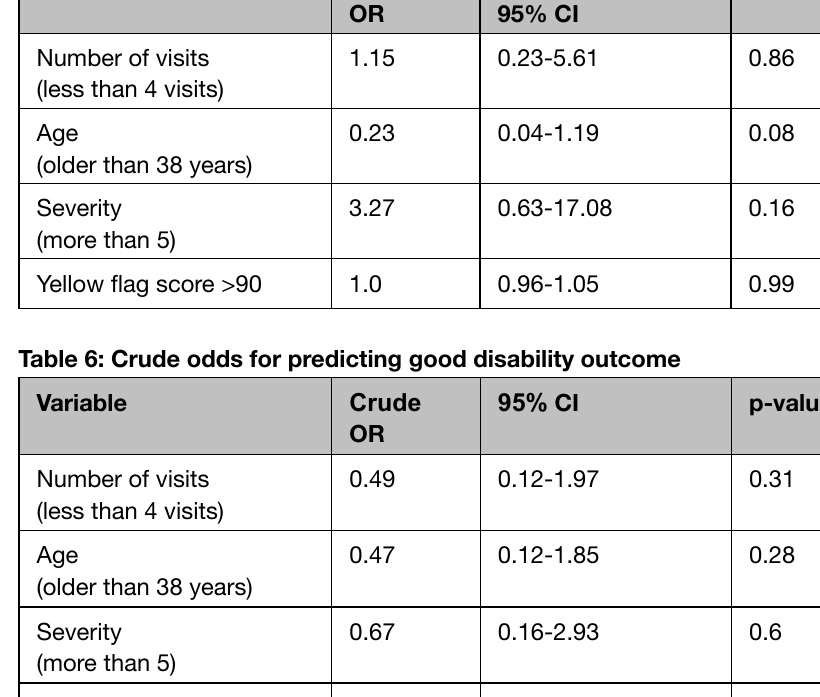
Table 5: Adjusted odds for predicting good pain outcome variable